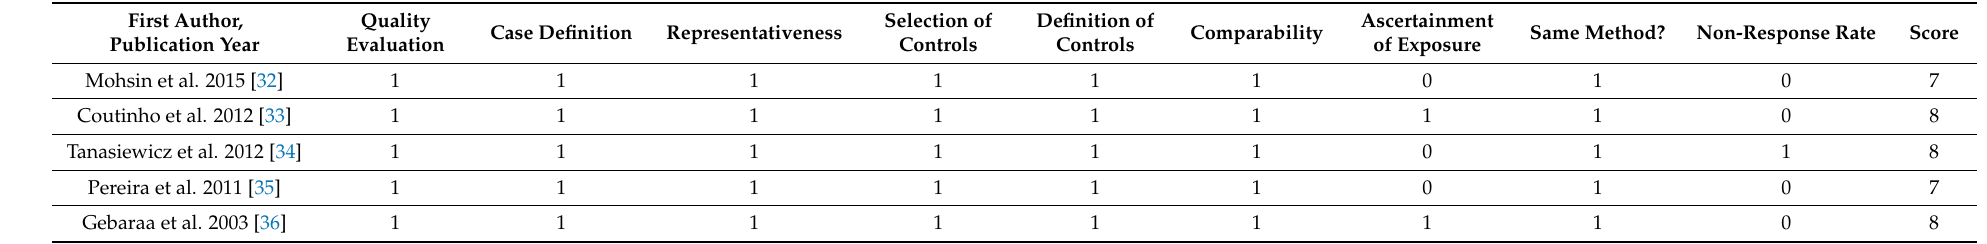
Table 4. The Newcastle–Ottawa Scale